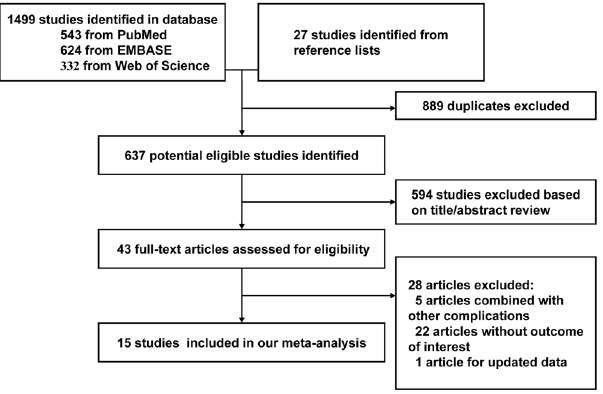
Figure 1. Flow diagram of the literature search and selection